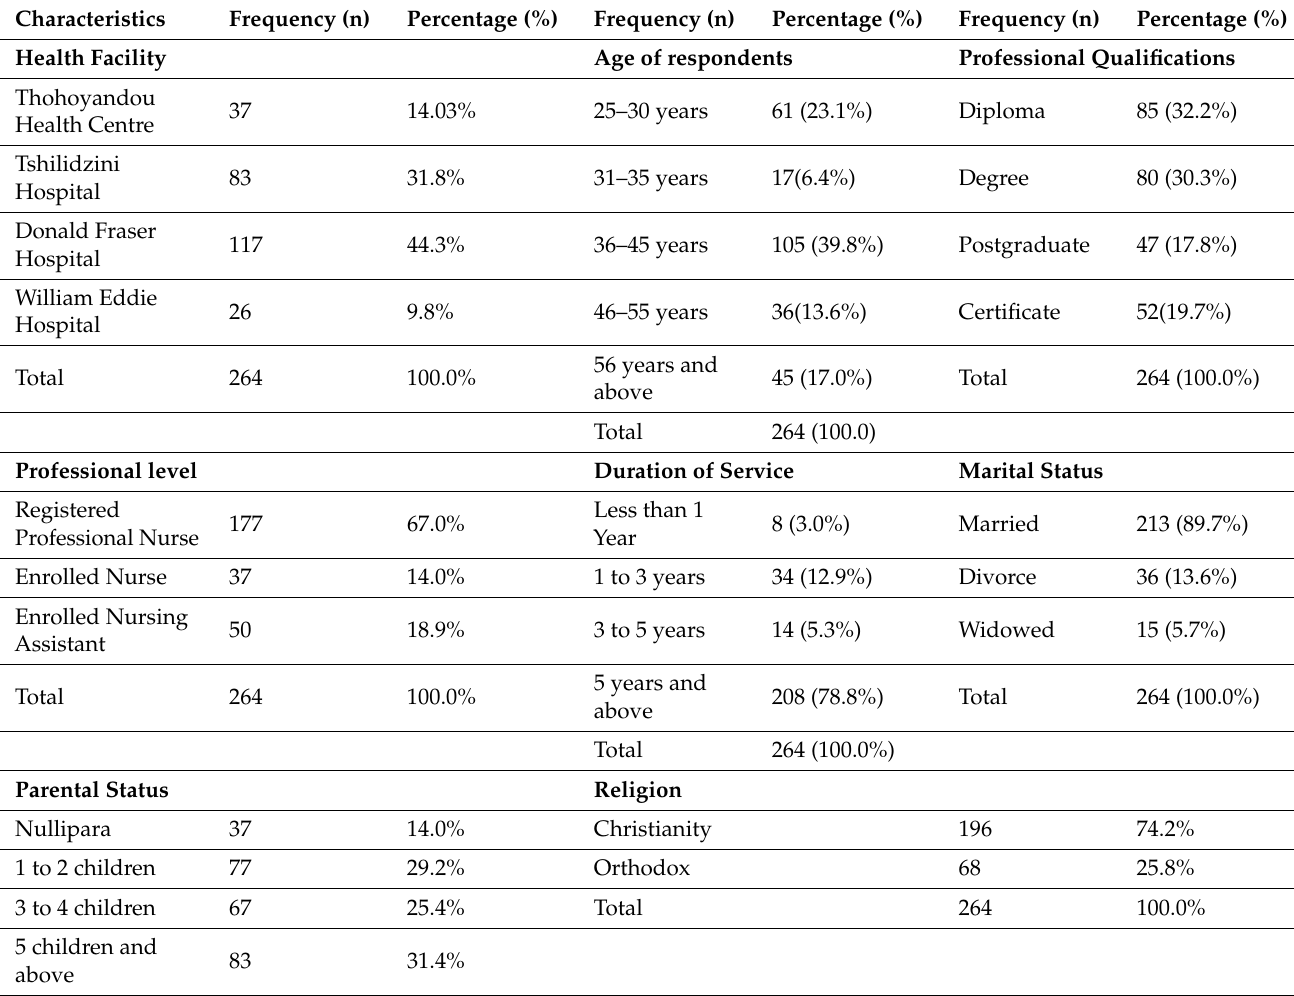
Table 1. Demographic information of